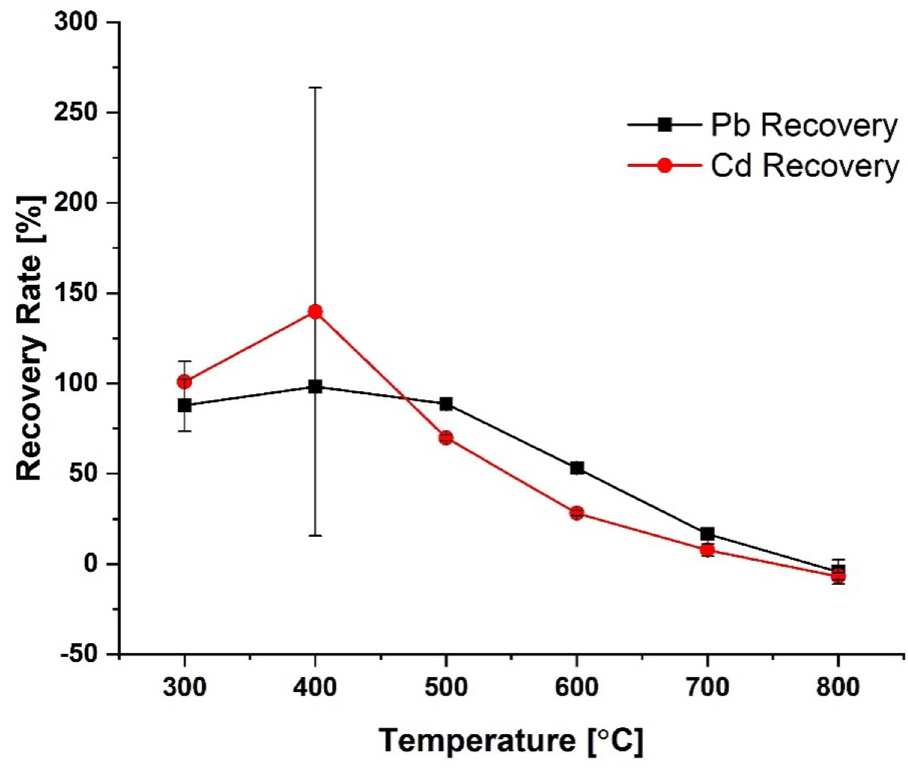
Fig 2. Optimization of the graphite furnace atomic absorption pyrolysis